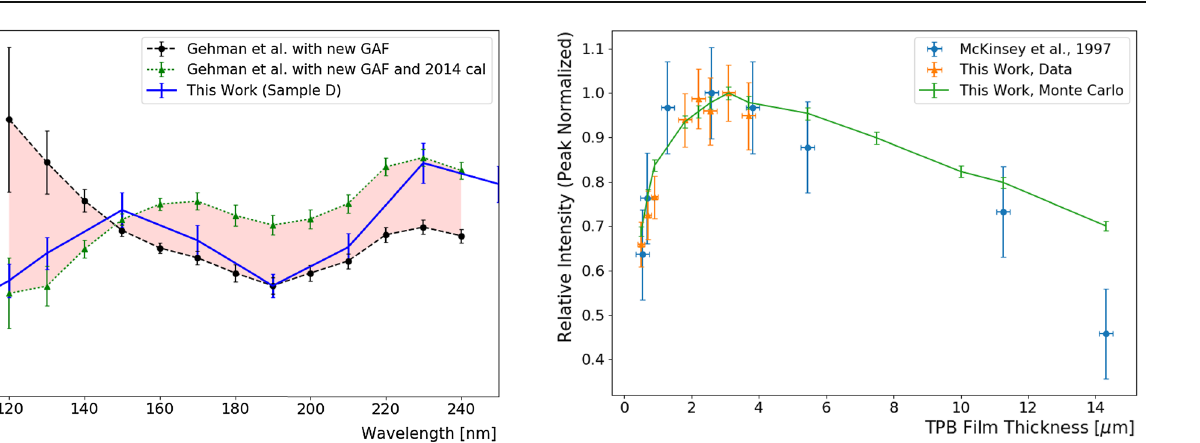
Fig. 23 Impact of re-analyzing data from [16] using the Monte Carlo model described in this work. The solid line shows the WLSE of a sam- ple of comparable thickness to that studied in [16]. The shaded region spanning the dashed and dotted lines illustrate the uncertainty in the photodiode calibration used in [16] at the time of the 2011 measure- ment